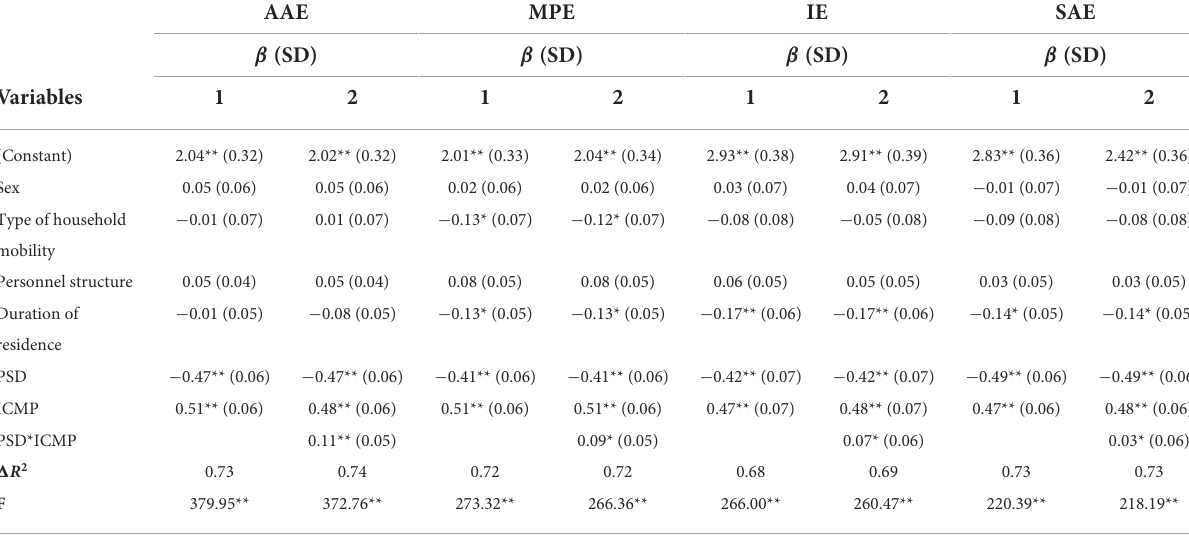
TABLE 8 Moderating effect of ICMP on the relationship between PSD and educational